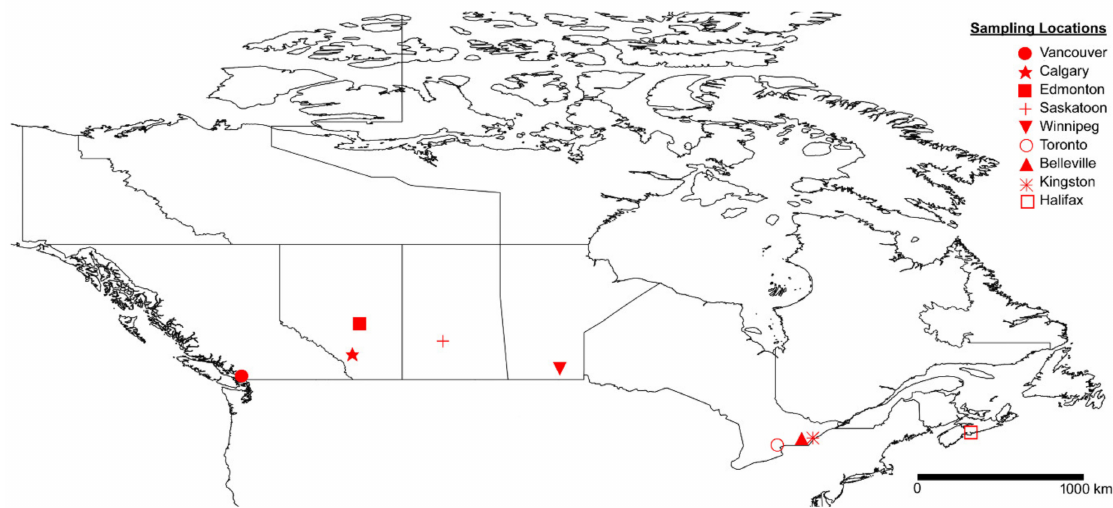
Figure 1. Map of Canada with marked sampling locations. Created using SimpleMappr